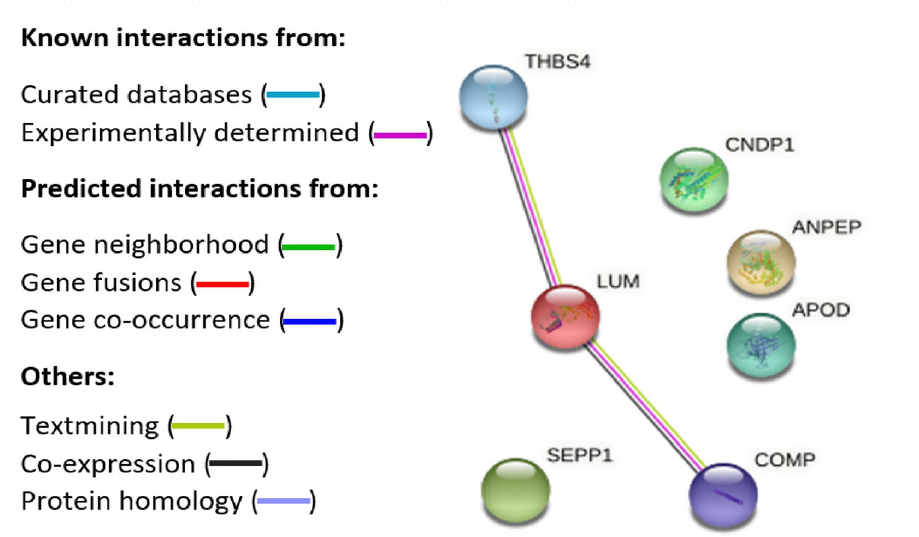
Figure 3. Protein–protein pathway analysis illustrating significantly downregulated proteins in POTS. Protein– protein interaction analysis of 7 out of 11 upregulated proteins with association networks detected by STRING in POTS. In the network figures, each protein is represented by a colored node while protein–protein interaction and association are represented by a line. The strongest network interactions in POTS were particularly associated with a hypercoagulable state, inflammation, and enhanced cardiac contractility and hypertrophy. Complete names of proteins are found in Table